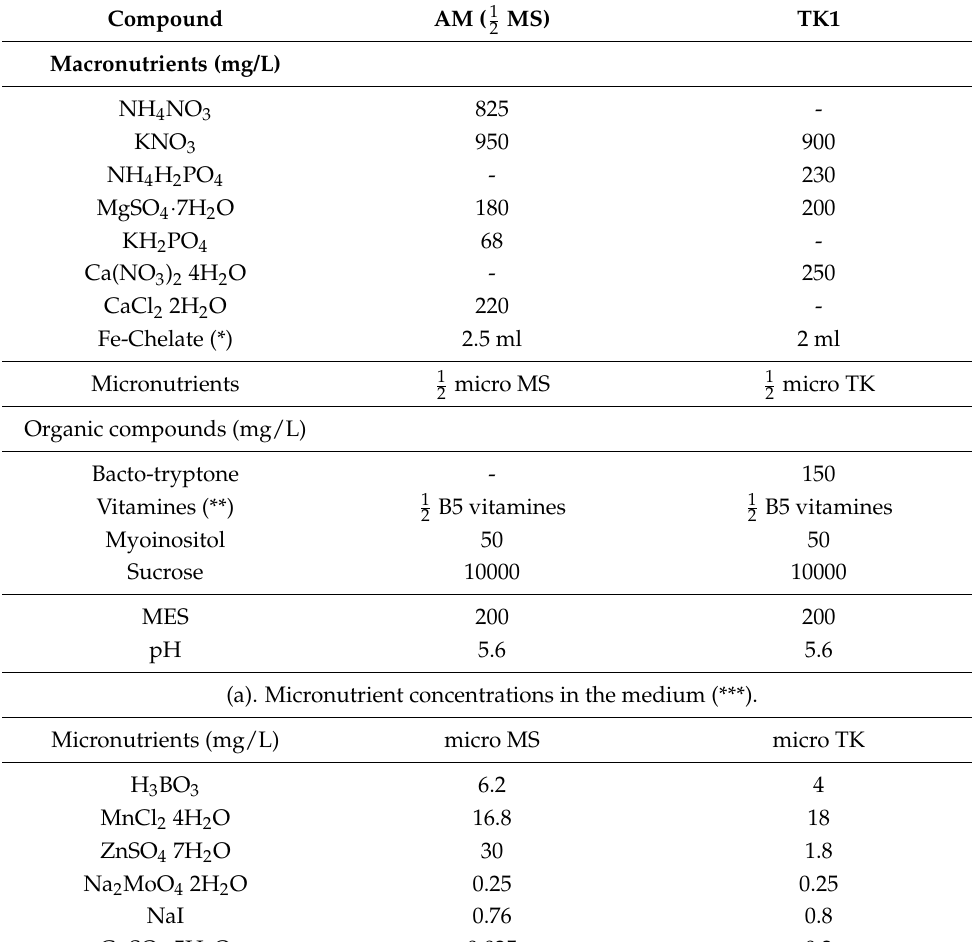
Table 1. Composition of different nutrients media (in mg/L) for in vitro growth of Arabidopsis seedlings (TK). Arabidopsis medium (AM; half-strength Murashige and Skoog Medium) [15] and for the optimized medium described in [9]